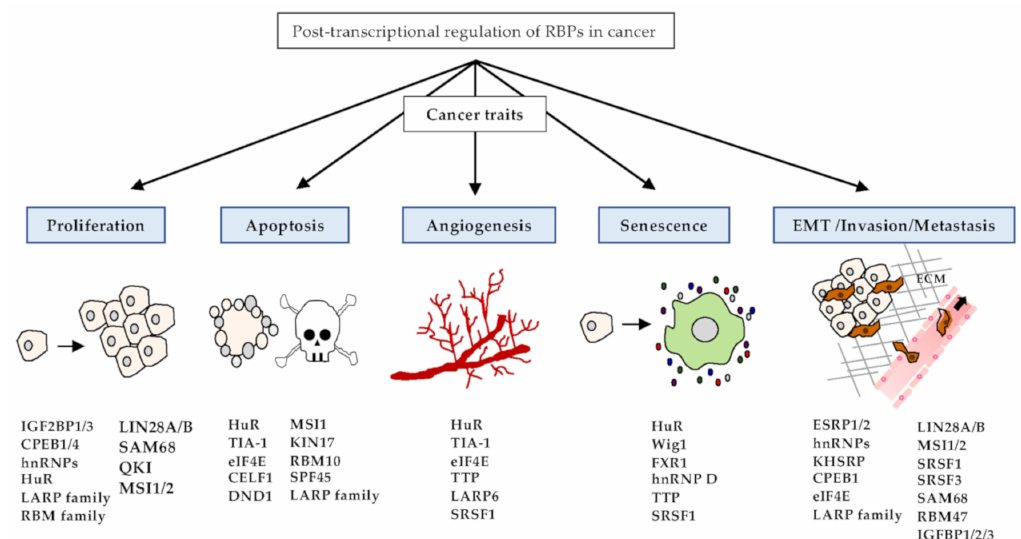
Figure 2. Functions of RBPs in cancer traits. RBPs play pivotal roles in the embodiment of various cancer traits, such as proliferation, apoptosis, angiogenesis, senescence, and EMT / invasion / metastasis. Representative RBPs of cancer traits are listed in the schematic